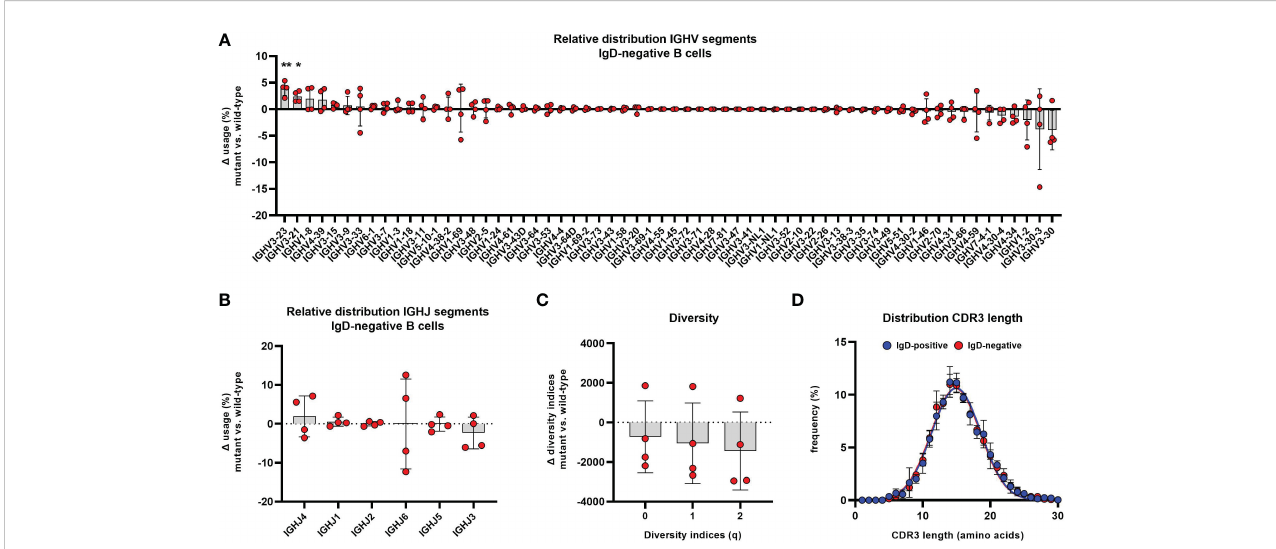
FIGURE 7 Altered distribution of V H segments in the IgD-negative mature naïve B cell population Distribution of different V H (A) and J H (B) segments used in CD19 + CD27 - CD21 + CD10 - IgM + IgD - mature naïve B cells is shown as relative difference compared to the matched IgD + counterpart. Symbols represent the D frequency IgD - /mutant versus IgD + /wild-type from individual samples and bars the mean ± SEM. V H and J H segments are ordered on the x-axis according to their mean relative difference (*, p < 0.05; **, p < 0.01; one sample t-test with hypothesized mean of 0). (C) Representation of species richness (q=0), Shannon diversity index (q=1) and Simpson diversity index (q=2) is shown as difference between IgD - and IgD + B cell subsets. Symbols represent the D value IgD - /mutant versus IgD + /wild-type of each parameter from individuals samples and bars the mean ± SEM. (D) Distribution of CDR3 IgH length in IgD + (blue) and IgD - (red) mature naïve B cells. Each symbol represents the mean frequency ± SEM of a distinct CDR3